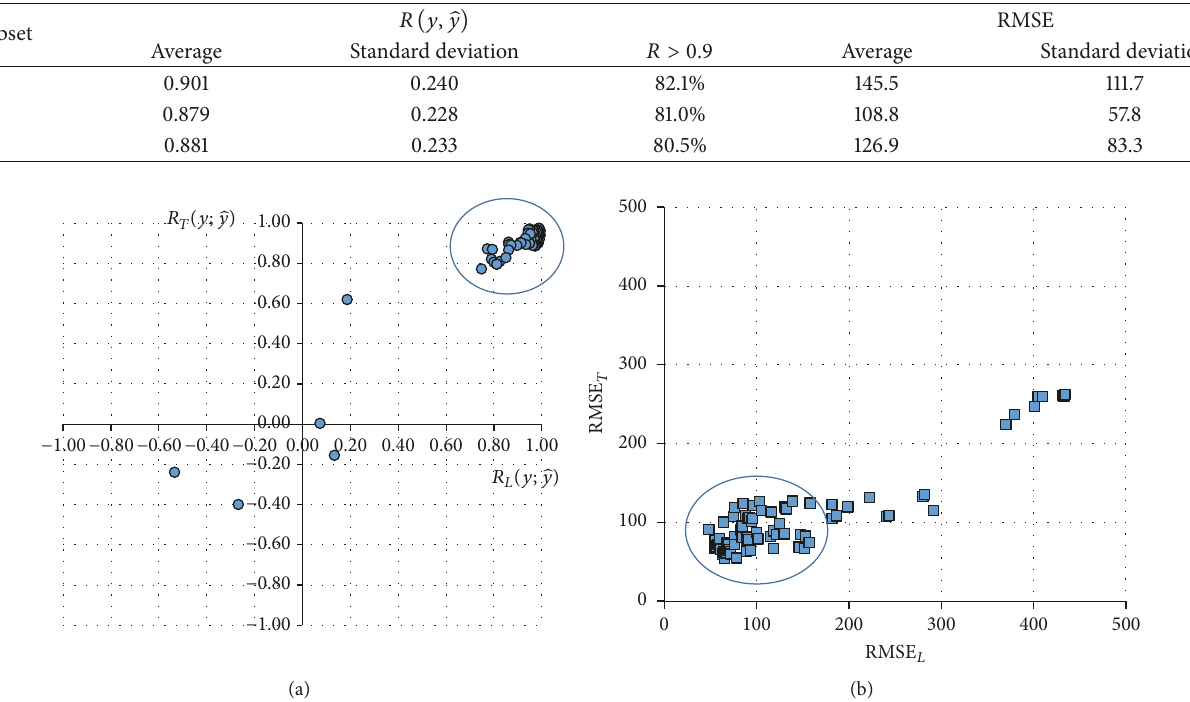
From (5), 𝐻 ≈ 2,646. According to the assumptions about the cardinality of 𝐿 subset and from inequality (6), NNP < 69